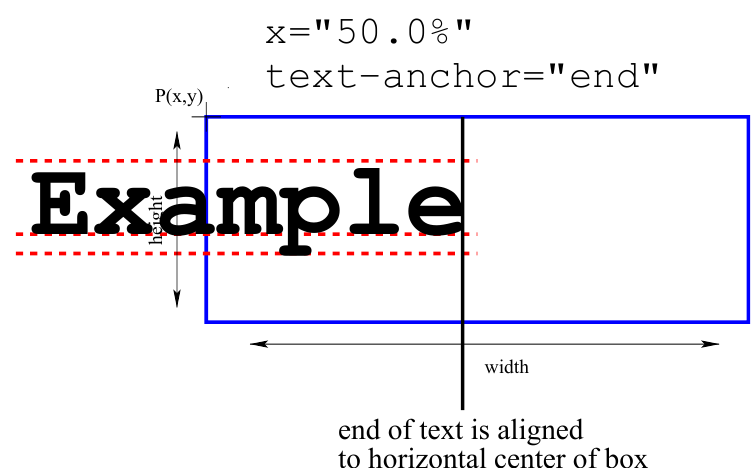
Figure 23: horizontal text alignment